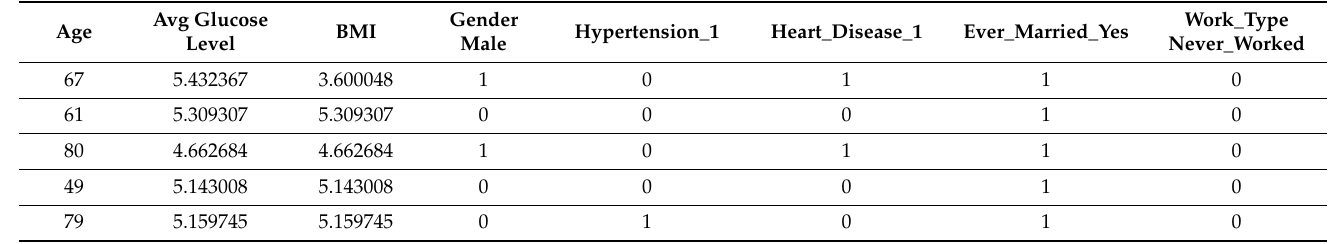
Table 2. The stroke prediction dataset after applying the one-hot